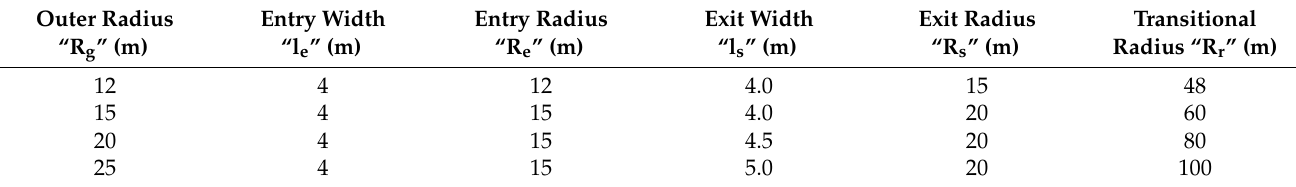
Figure 22. Single-lane approach for an outer radius of 20 m according to [6]. Table 6. Design elements for roundabout entry and exit according to [6].